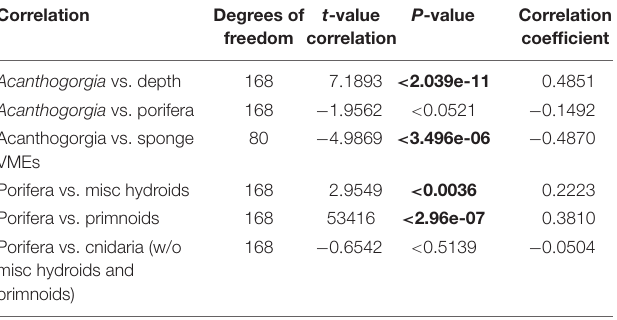
t -value P -value Correlation freedom correlation coefficient